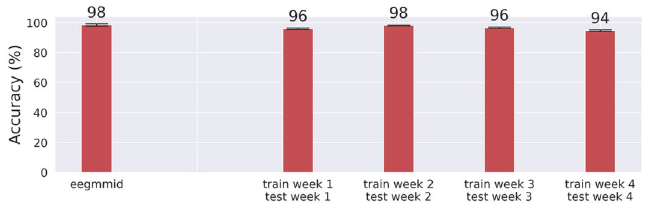
Figure 2. Single-day personal identification. The means of 10-person identification accuracies and their standard errors resulted from the single-day EEGMMID data (the leftmost bar) and our multi-day EEG data (the four bars on the